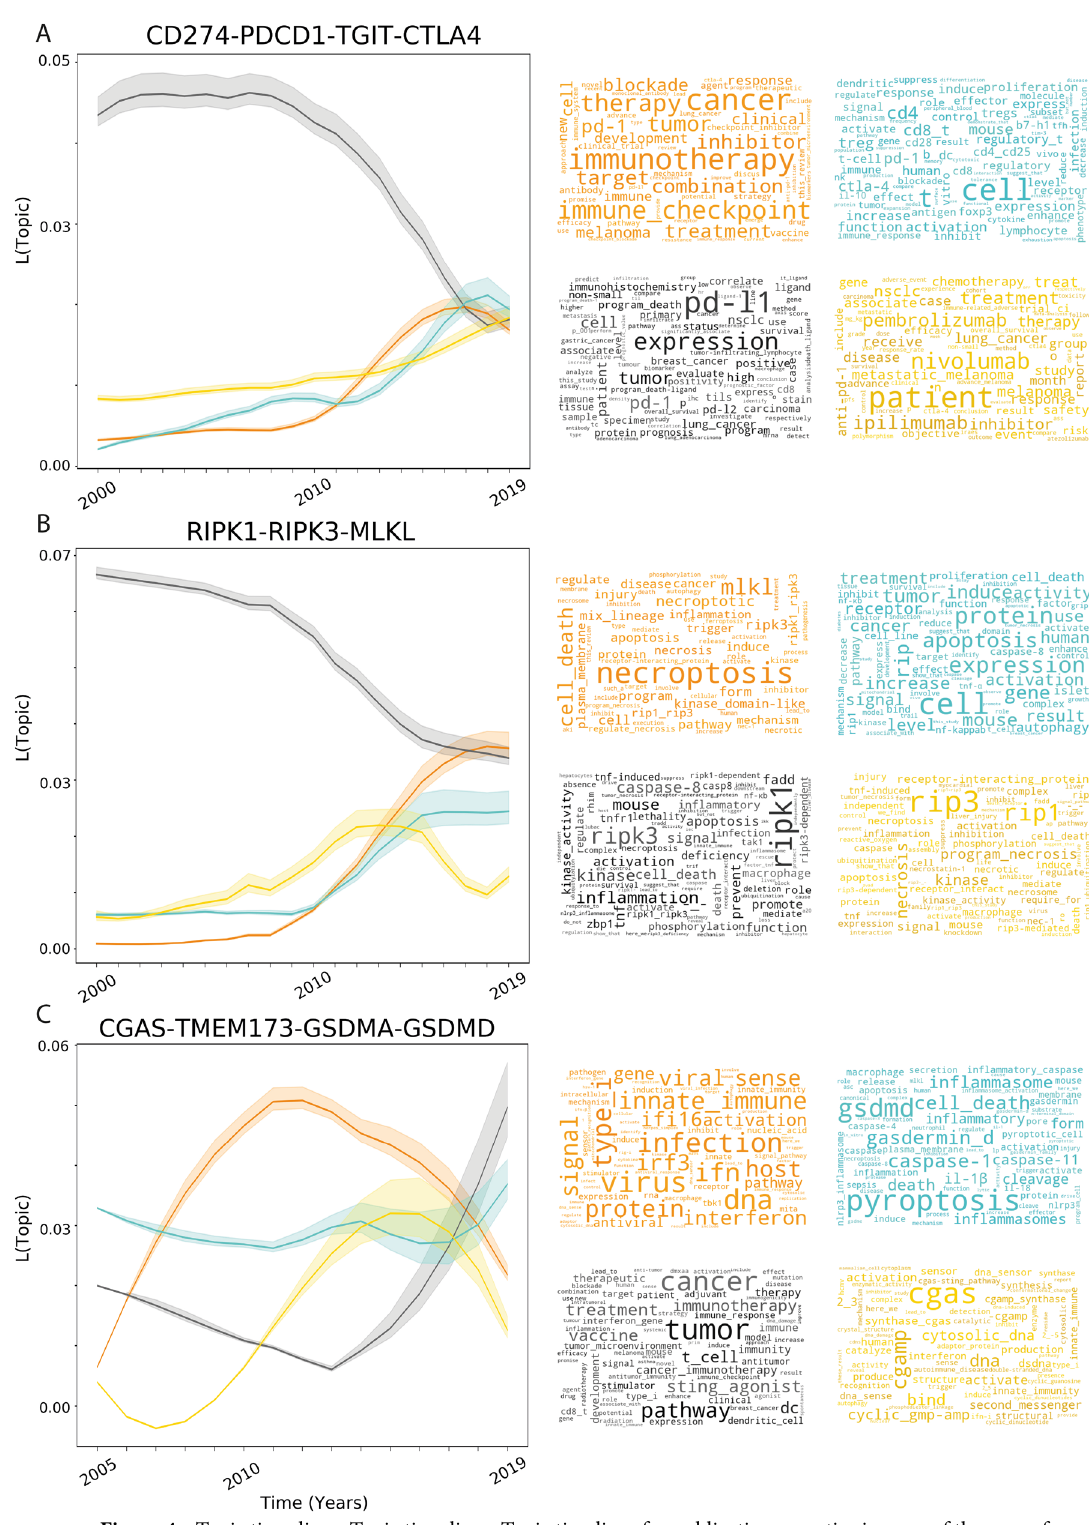
Figure 4. Topic time-lines. Topic time lines. Topic timelines for publications mentioning any of the genes for the immune checkpoint inhibitor (A) , necroptosis (B) and pyroptosis (C) pathways. The x-axis represents the time in years and the y-axis represents the likelihood of a given topic. Colors represent different topics defined by the keywords contained in the correspondent word clouds. The latent four topics were obtained using Non- Negative-Factorization all publications annotated with the genes after disambiguation. Word clouds were created using the phrases with highest TFIDF for groups of publications belonging to each topic. All timelines show at least one rising topic after 2013 that represents the reason why these genes became trendy, their implications in human disease: immune checkpoint inhibitors and monoclonal antibodies (yellow and orange in A ), activation of necroptosis (orange in B ), agonists of STING1 in cancer (black in C